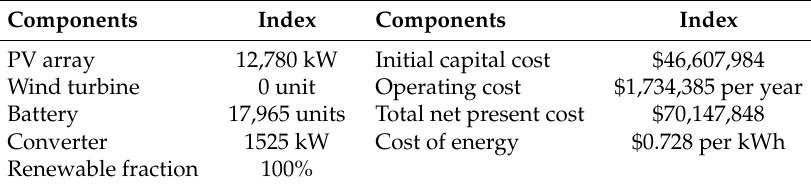
Figure 5. The suggested configuration (created by the authors). Table 5. Optimal configuration for Chiang Mai University (created by the authors).